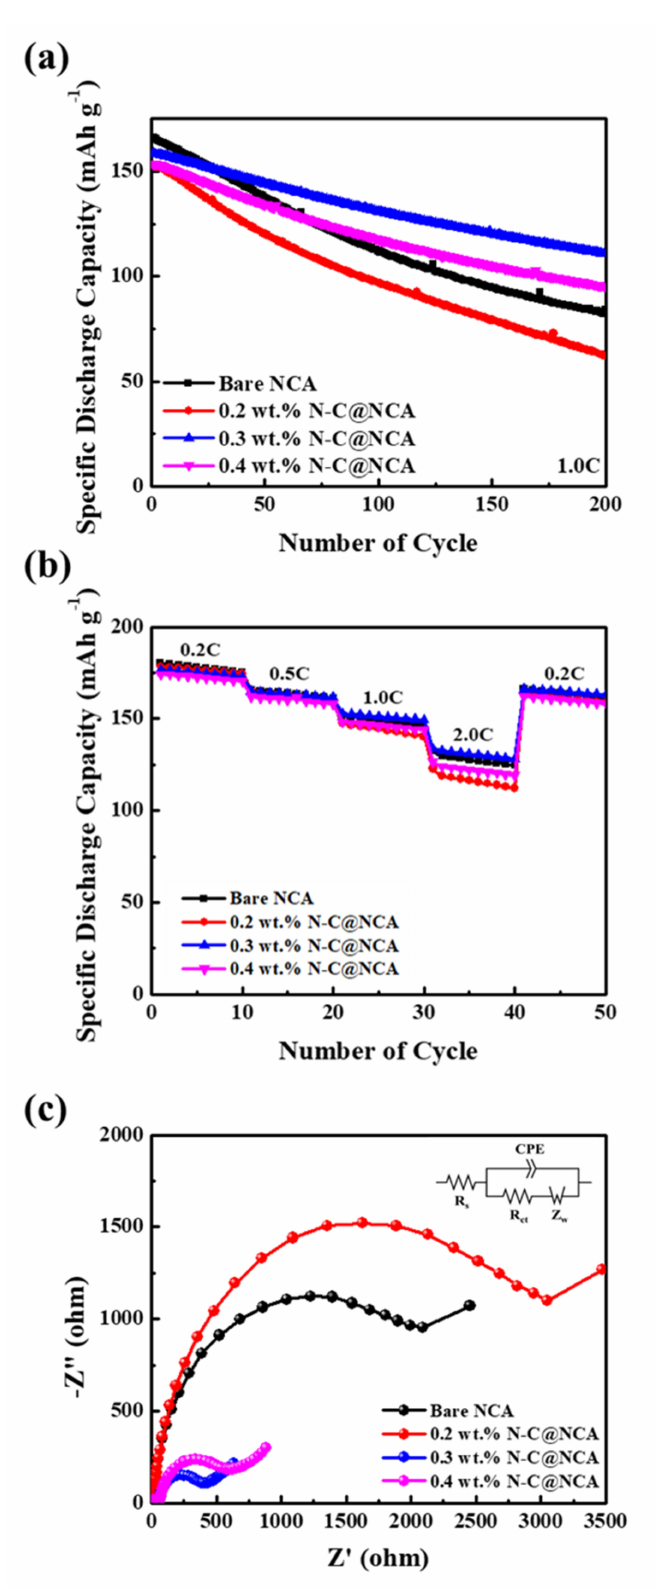
Figure 7. ( a ) Cycling performance at a current density of 1.0 C; ( b ) rate capability; ( c ) EIS analysis after 200 cycles at a current density of 1.0 C for bare NCA, 0.2 NC@NCA, 0.3 NC@NCA, and 0.4